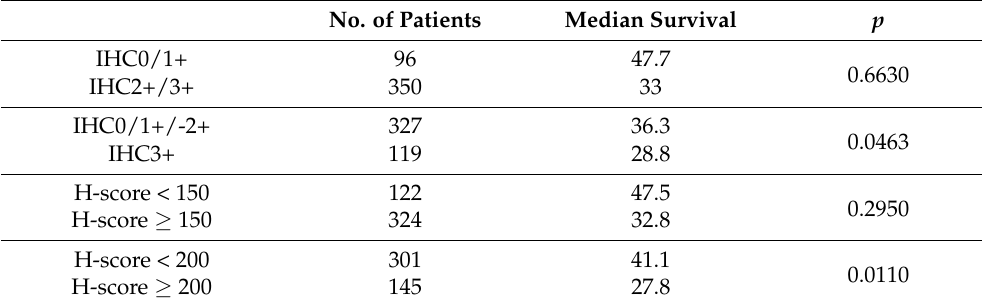
Table 3. Association of MET expression with survival by using IHC2+/IHC3+ or H- score ≥ 150 or ≥200 as cut -off (Kaplan-Meier method).